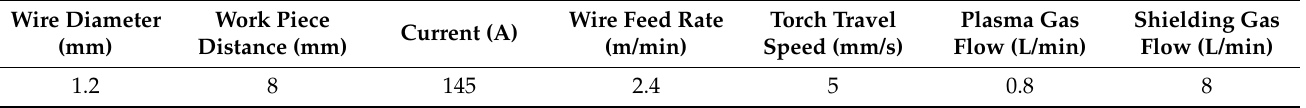
Table 1. Process parameters for the WAAM walls studied in this paper.